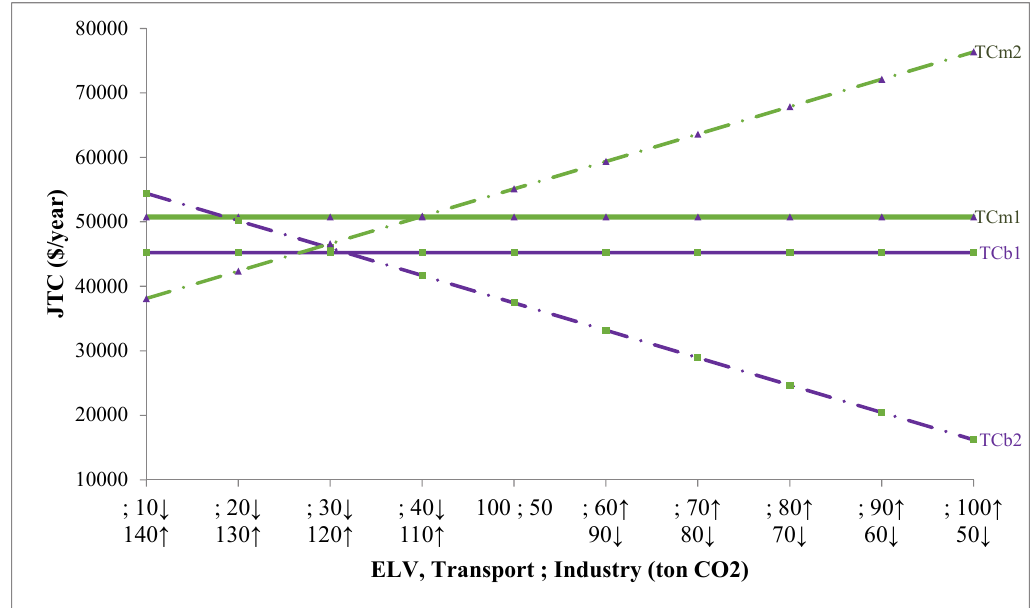
Fig. 7. The effect of changing in ELV on total cost and total emission